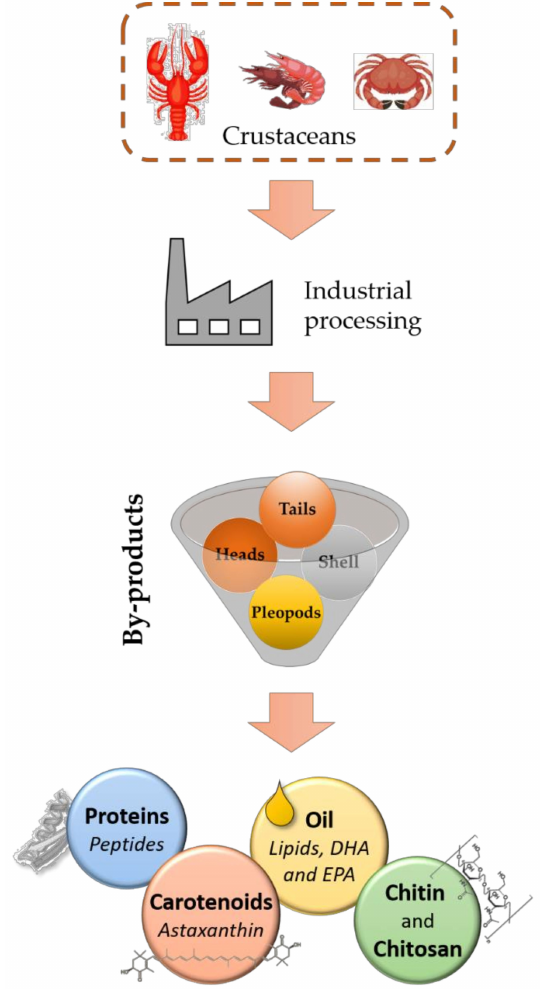
Figure 1. Valuable compounds derived from crustacean processing